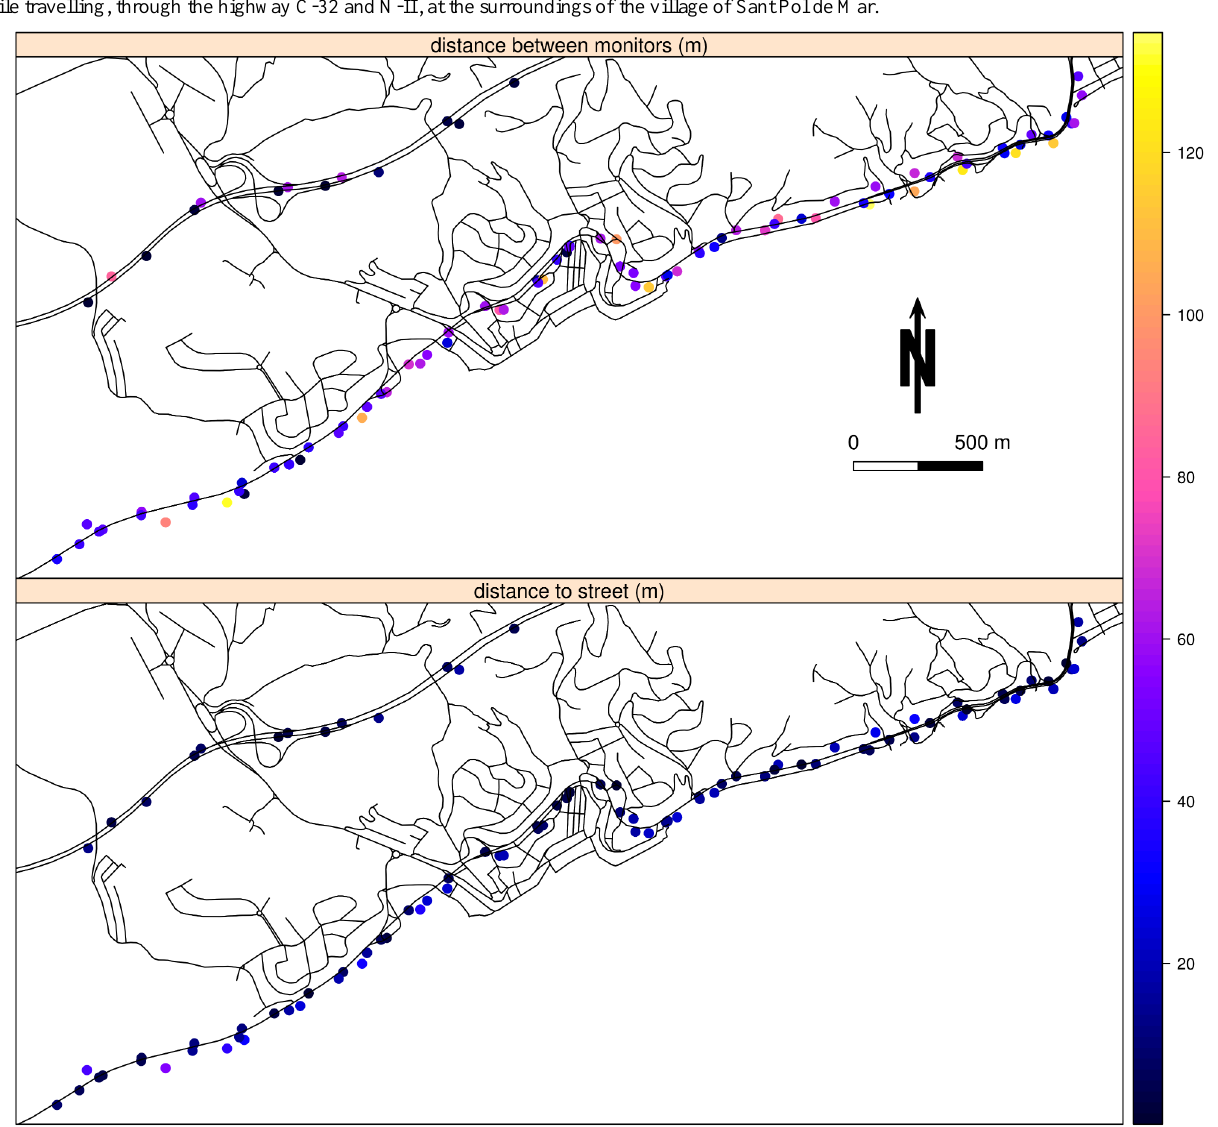
Figure 2. Comparison of distances between smartphone and Global Positioning System (GPS) tracker concomitant locations and to nearest street, while travelling, through the highway C-32 and N-II, at the surroundings of the village of Sant Pol de